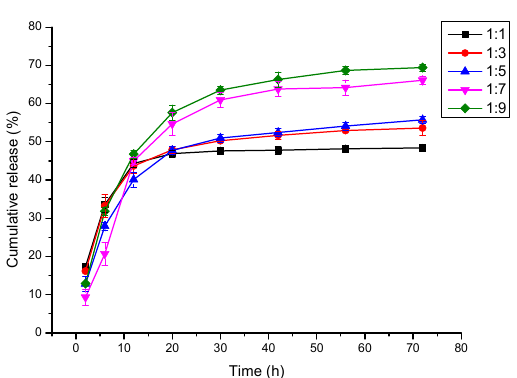
Figure 6. Cumulative release of Cur from PLA/PEG/Cur CNFs with the different weight ratio (PEG:PLA).